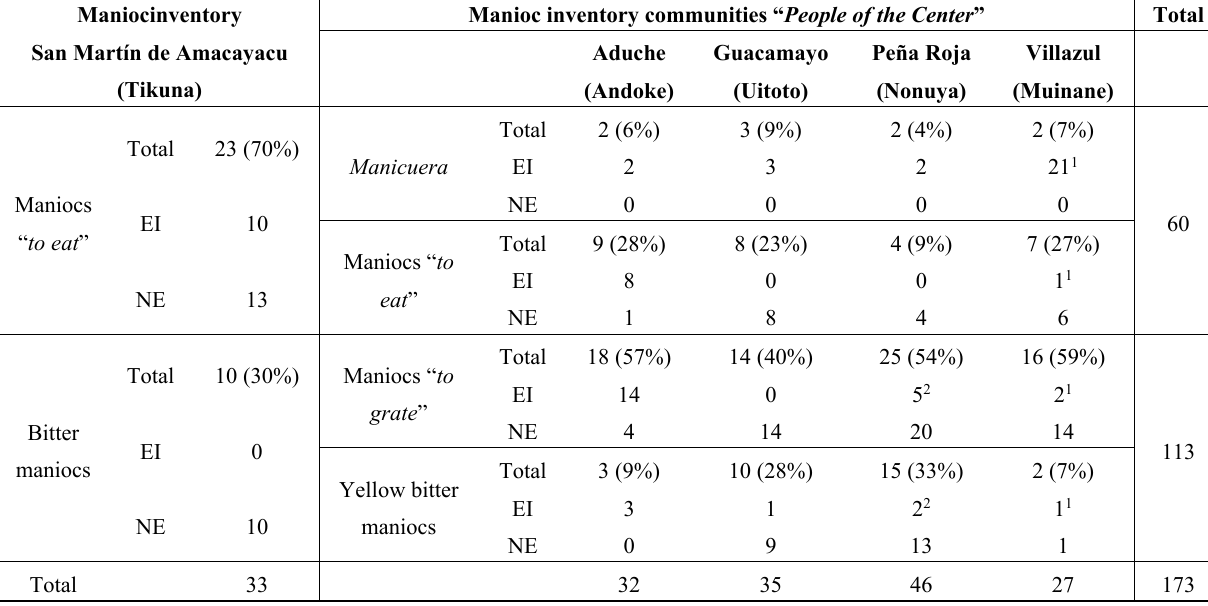
Table 1. Local manioc classification and diversity (number of landraces and between brackets percentage within a community) in five indigenous communities of the Colombian Amazon. T = Total number of manioc landraces per class. EI = Number of manioc landraces associated to ethnic identity in each class; NE = Number of manioc landraces not associated to ethnic identity in each